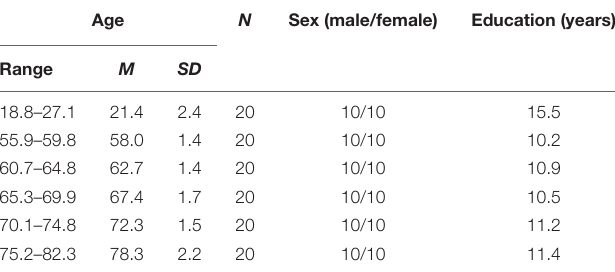
TABLE 1 | Summary of participant demographics across age